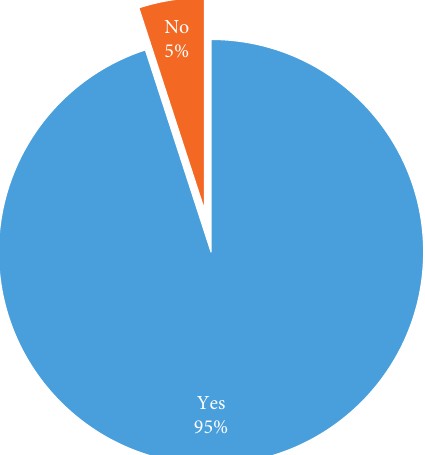
Figure 14: Kola nuts marketing systems should be controlled as for cocoa in Ghana ( N � 403).